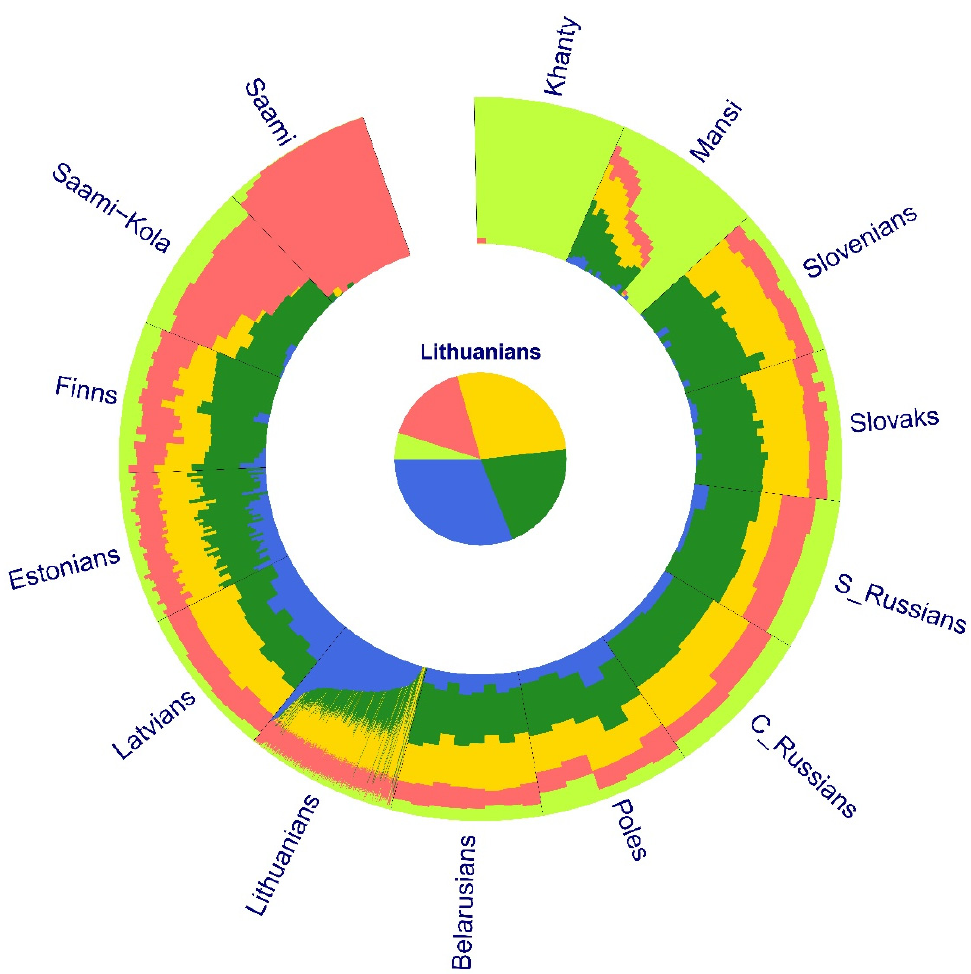
Figure 2. Population structure inferred from ADMIXTURE analysis on autosomal SNPs of Lithuanians and 13 external populations. The lowest cross-validation error (K = 5) shows the predominant genetic component (in blue) of Lithuanians.